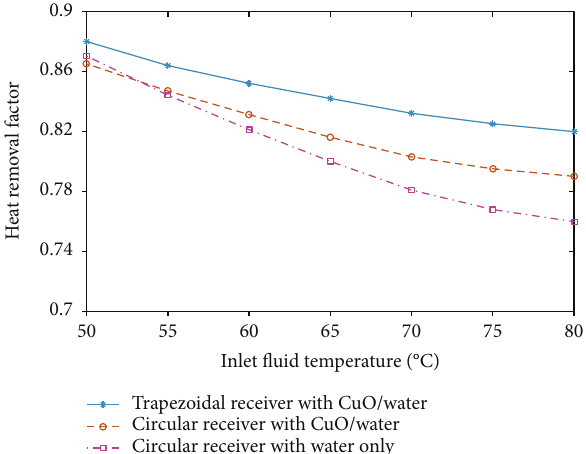
Figure 5: Variations of thermal and electrical e ffi ciency with absorber thickness.